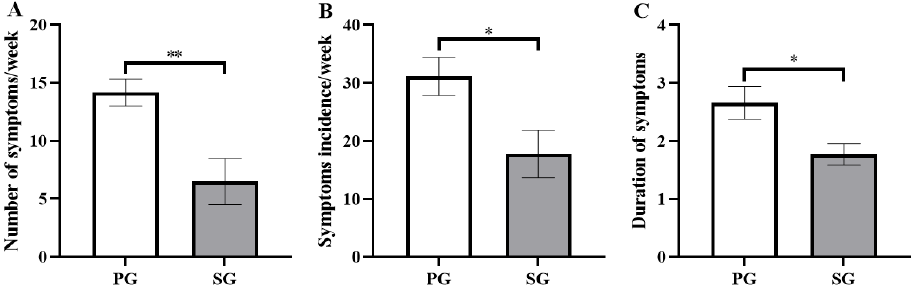
Figure 2. Comparison of the effects of the prebiotic and synbiotic on the upper respiratory tract infection questionnaire during high-intensity training in elite football players. Results are presented as mean ± SEM. PG: prebiotic group (n = 15); SG: synbiotic group (n = 15). ( A ) Total number of symptoms occurring in all subjects per week. ( B ) Incidence of symptomatic subjects per week. ( C ) Duration of symptoms. *: p < 0.05; **: p < 0.01.